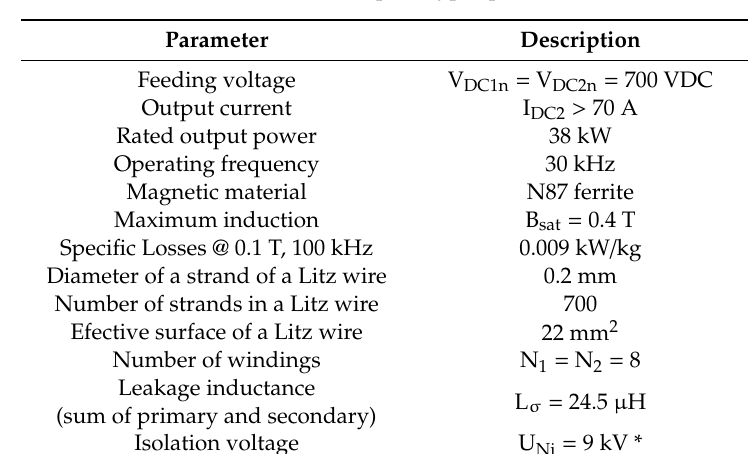
Table 5. Second MFT prototype